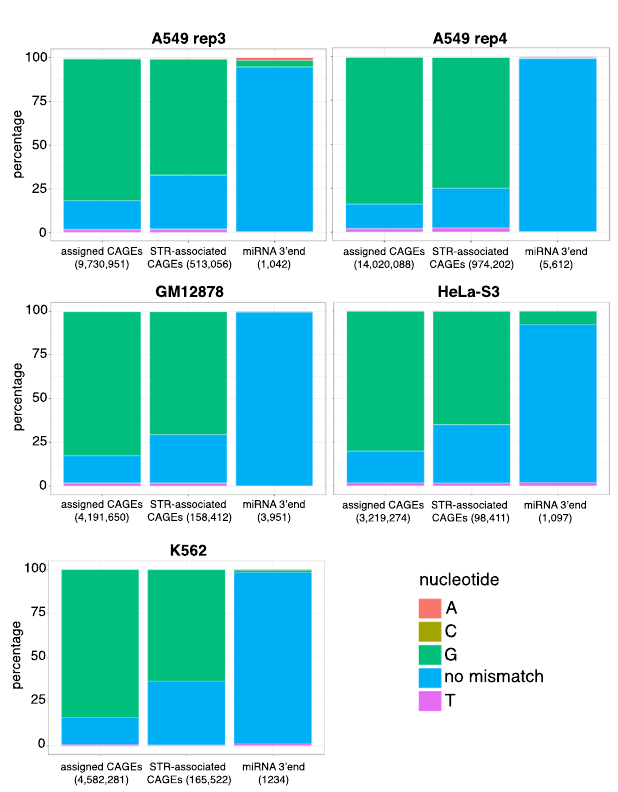
Fig. 2 CAGE tags initiating at STRs are truly 5 ’ -capped. G bias in ENCODE CAGE tags (bam fi les from nuclear fraction, polyA + ) was assessed at FANTOM5 CAGE peaks assigned to genes (positive control) and CAGE peaks initiating at STRs. G bias at pre-microRNA 3' ends was also assessed as a negative control. Five libraries were analyzed corresponding to A549 (replicates 3 and 4), GM12878, HeLa-S3, and K562 cells. The number of intersecting tags in each case is indicated in the bracket.